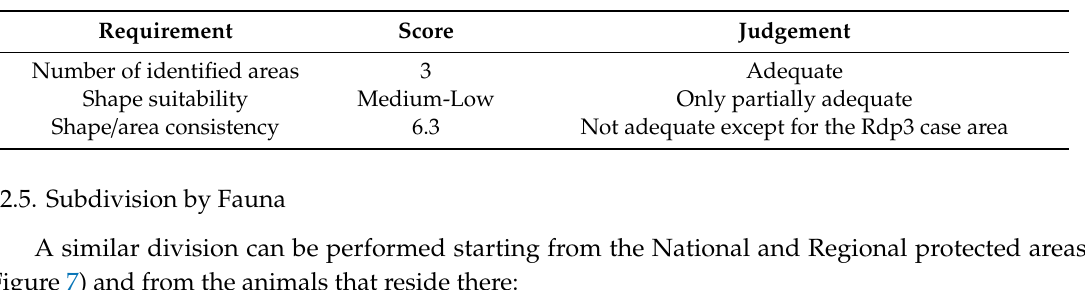
Table 6. Assessment of the criterion: subdivision by